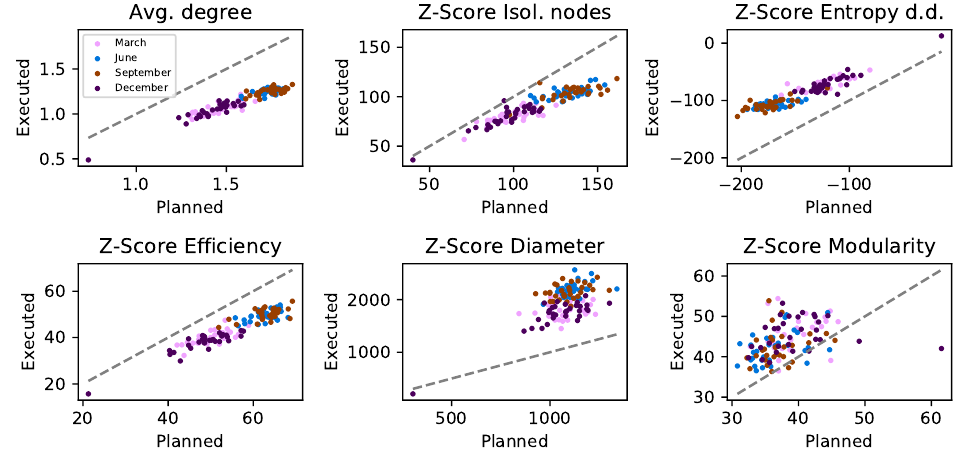
Figure 6. Comparing planned and executed operations. Each panel depicts a scatter plot of a network metric, for the executed operations and as a function of the planned ones. Colors of points indicate the respective month, see legend in the first panel. Note that only metrics with a significant Z-Score are here reported. With the exception of the average degree, all values correspond to the Z-Score of the